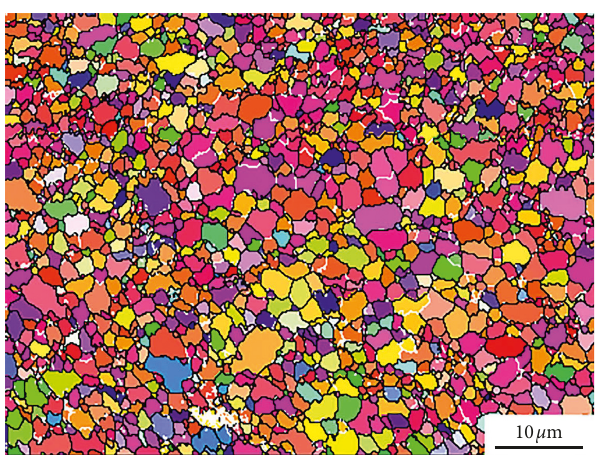
Figure 9: Orientation map of the sample after three-pass